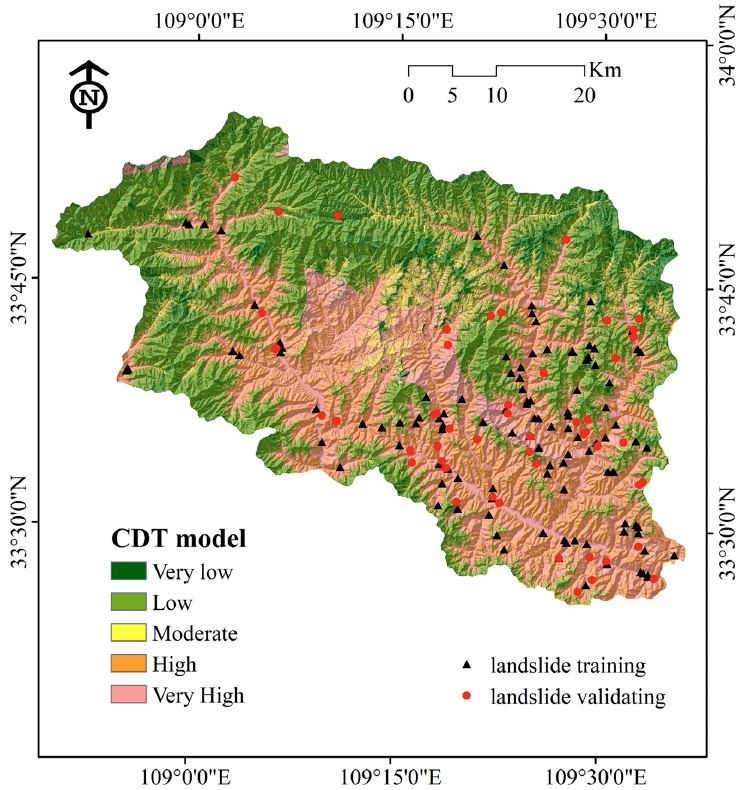
Figure 7. Landslide susceptibility map using the CDT model.